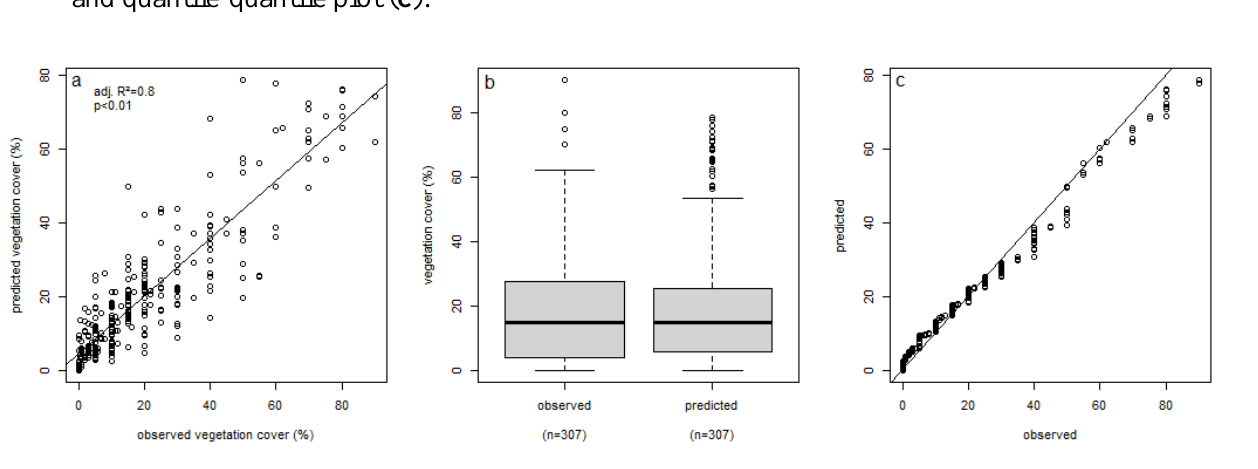
Figure 6. Comparison of observed and predicted values with linear regression ( a ), boxplot ( b ), and quantile-quantile plot ( c